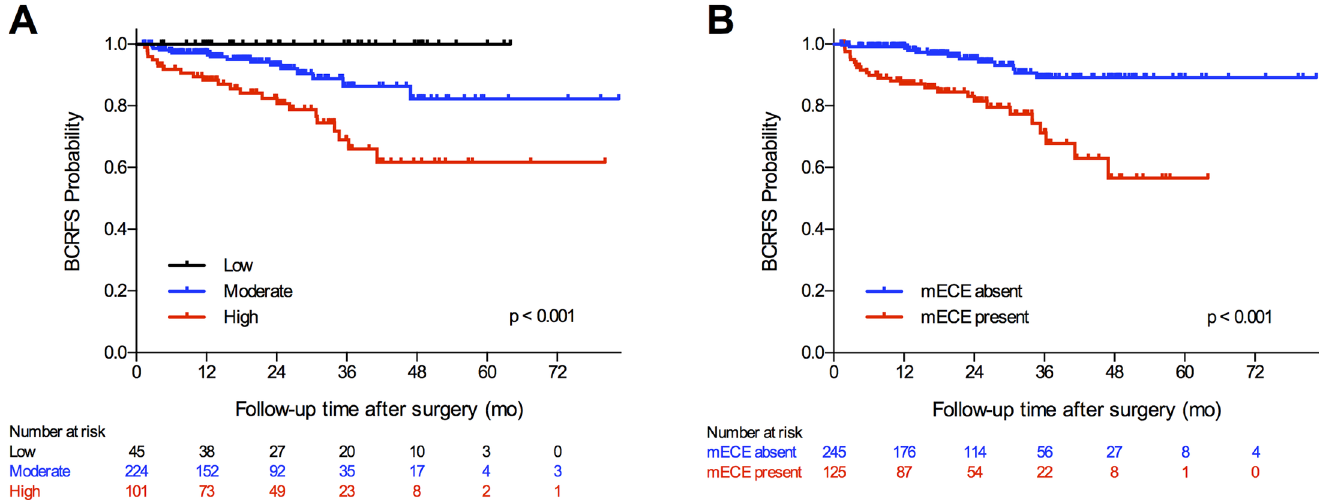
Fig 2. Kaplan-Meier analysis of biochemical recurrence-free survival for patients after radical prostatectomy. (A) By multiparametric magnetic resonance imaging suspicion score. (B) By extracapsular extension on magnetic resonance imaging. BCRFS = biochemical recurrence-free survival; mECE = extracapsular extension on magnetic resonance imaging; SVI = seminal vesicle invasion on magnetic resonance